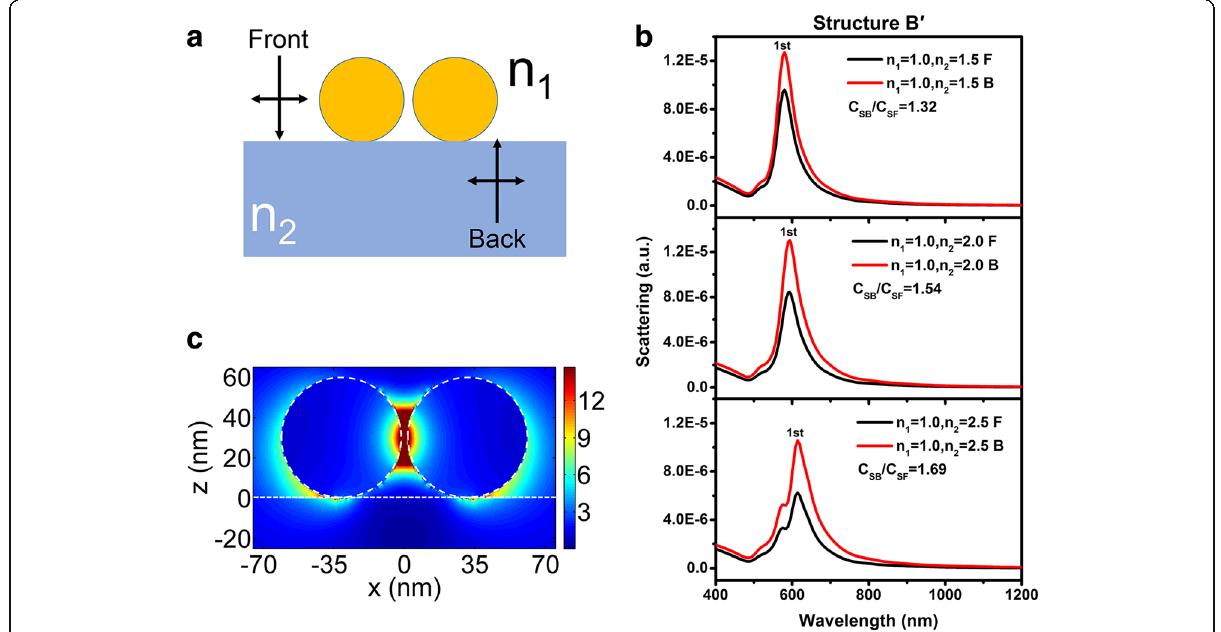
Fig. 9 a Schematic diagrams of structure B ′ used for FDTD simulations. b Scattering spectra for varying n 2 = 1.5, 2.0, and 2.5 of structure B ′ . Light is incident normally from air (denoted as black lines) and substrates (denoted as red lines). c Polarization electric field distributions of structure B ′ with n 2 = 1.5 at 532